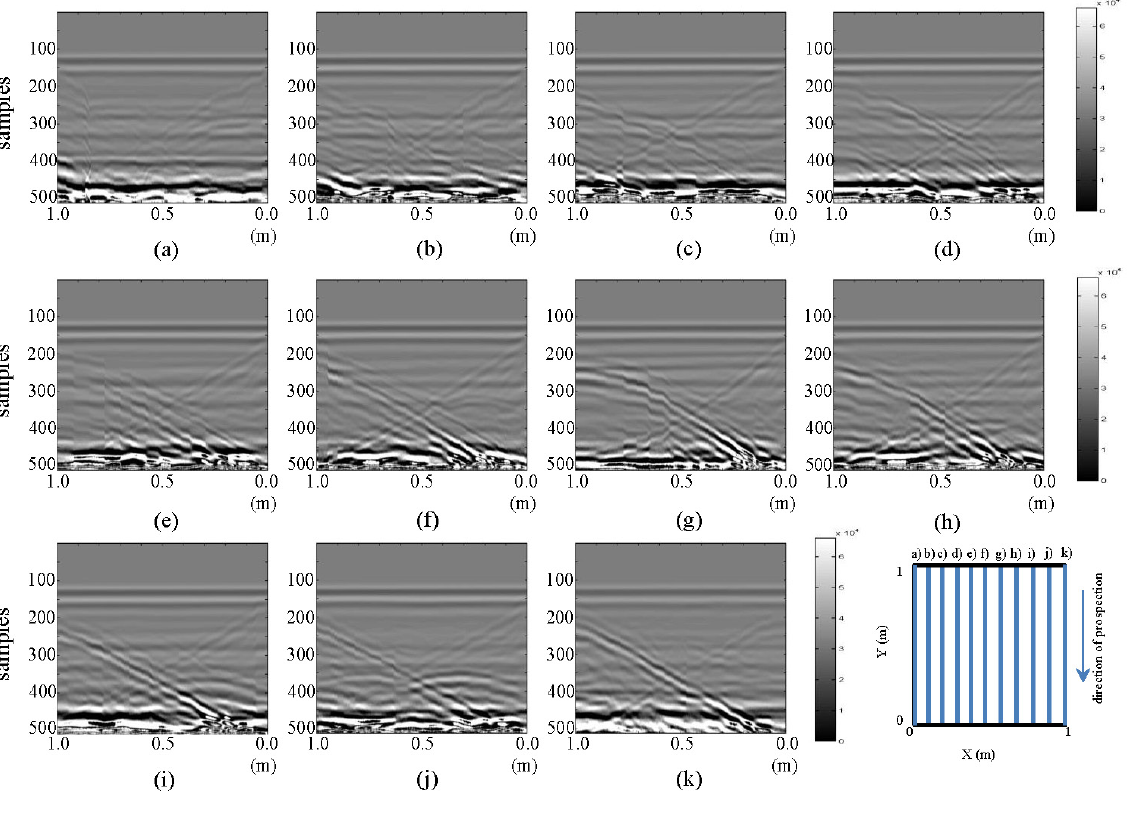
Figure 4. Vertical profiles: raw images for the initial state. ( a – k ) are profiles s12 to s22,